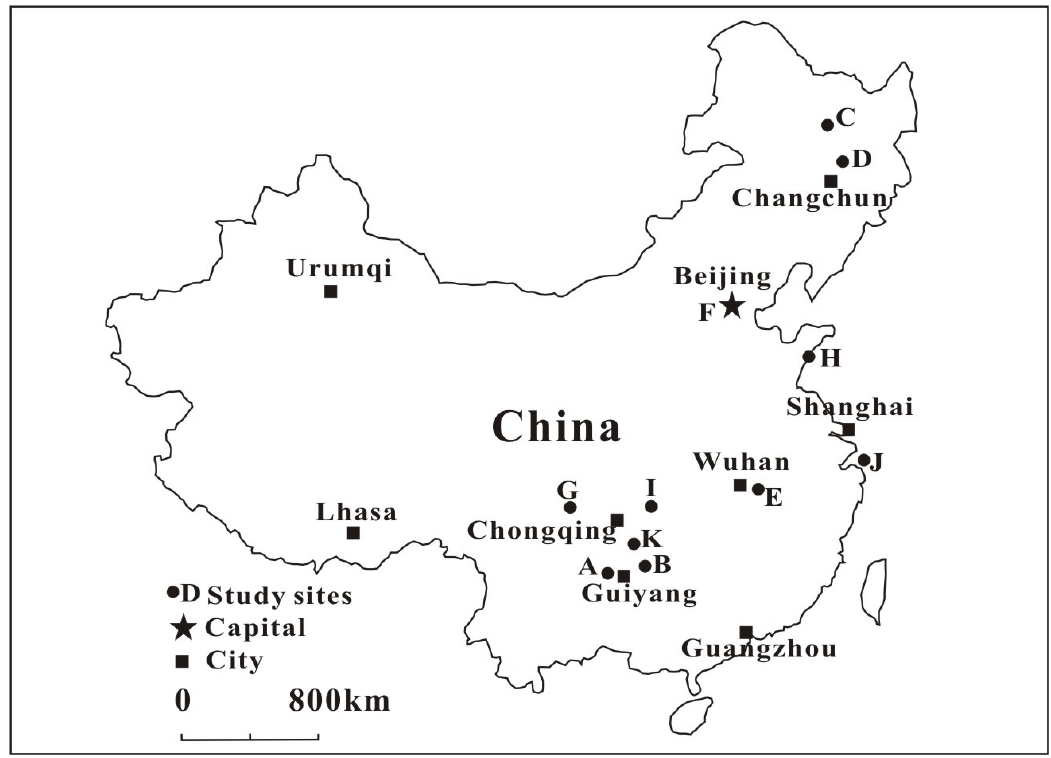
Figure 1. Location of study sites of the fish Hg survey in China.